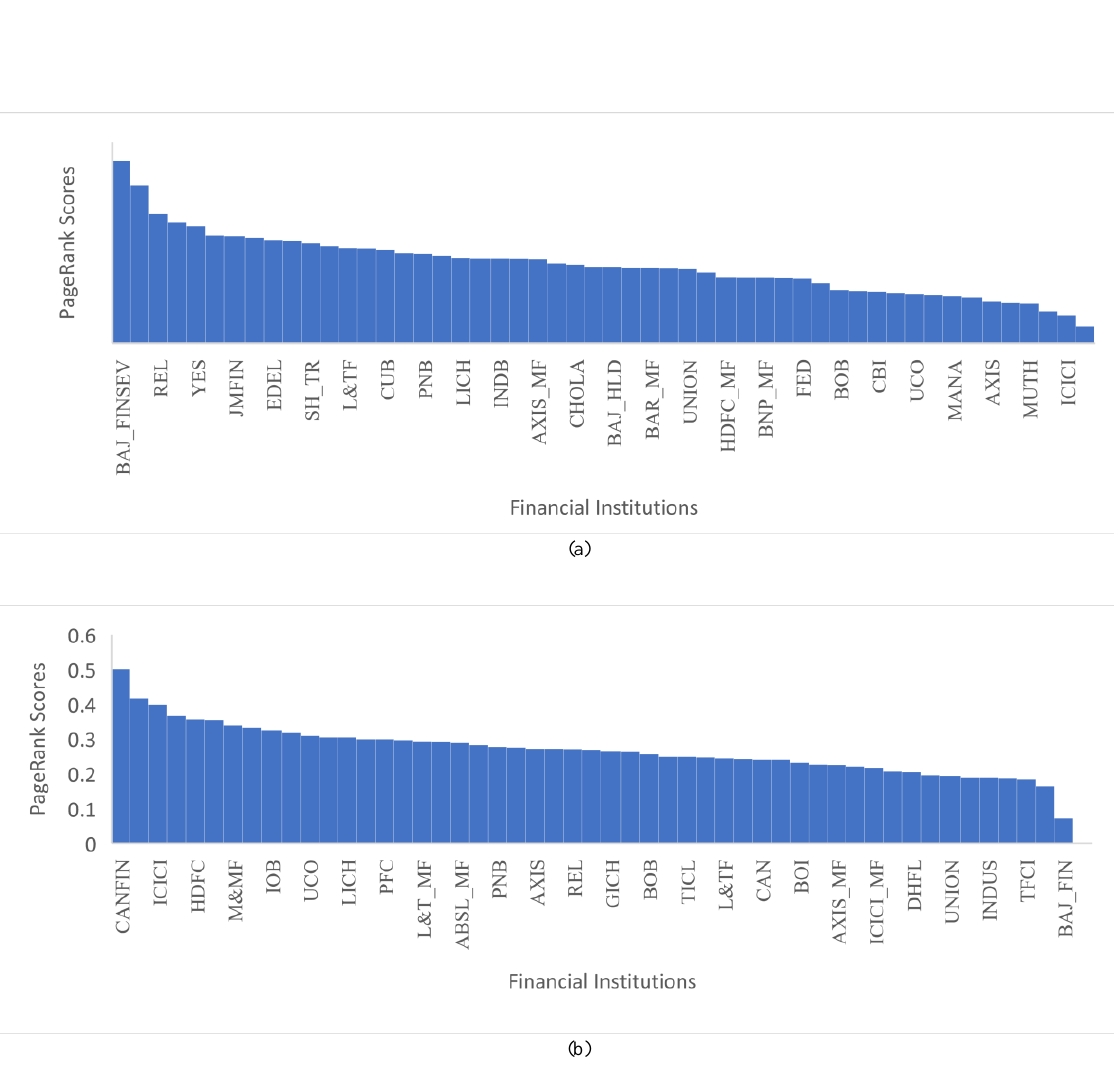
Figure 2. Page Rank Centrality for (a) Pre-crisis period (b) Crisis